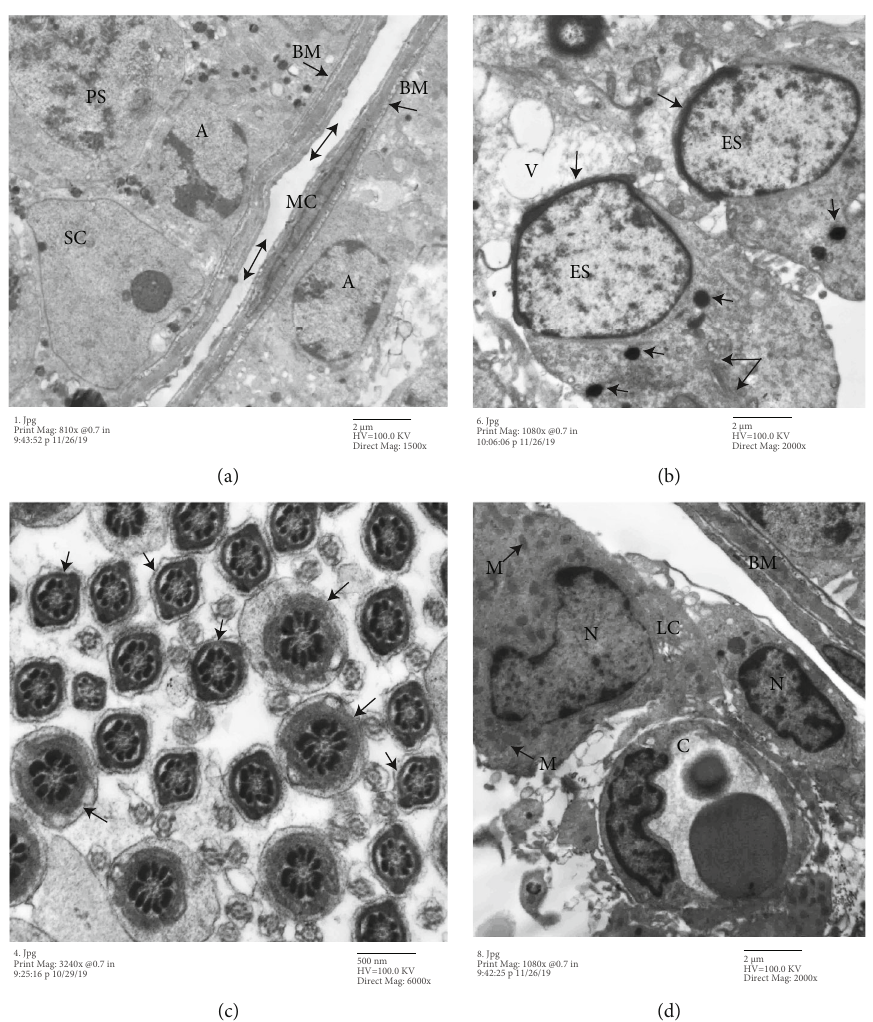
Figure 7: Electron micrographs of a seminiferous tubule of the ADMSC-treated group. (a) Regular basement membrane (BM) with normal myoid cells (MC). Normal space between two seminiferous tubules (double head arrow). Normal type A spermatogonia (A), primary spermatocyte (PS), and Sertoli cell (SC). (b) Early spermatid (ES) with an acrosomal cap (arrow), lipid droplets (arrowhead), and mitochondria around a growing axoneme (double arrow). Few vacuolations in between the cells (V). (c) The lumen of a seminiferous tubule contains di ff erent transverse sections of normal sperms and central axoneme with mitochondrial sheath (arrow) and fi brous sheath (arrowhead). (d) Interstitial tissue contains Leydig cells (LC) with euchromatic nuclei (N), mitochondria (M), and blood capillary